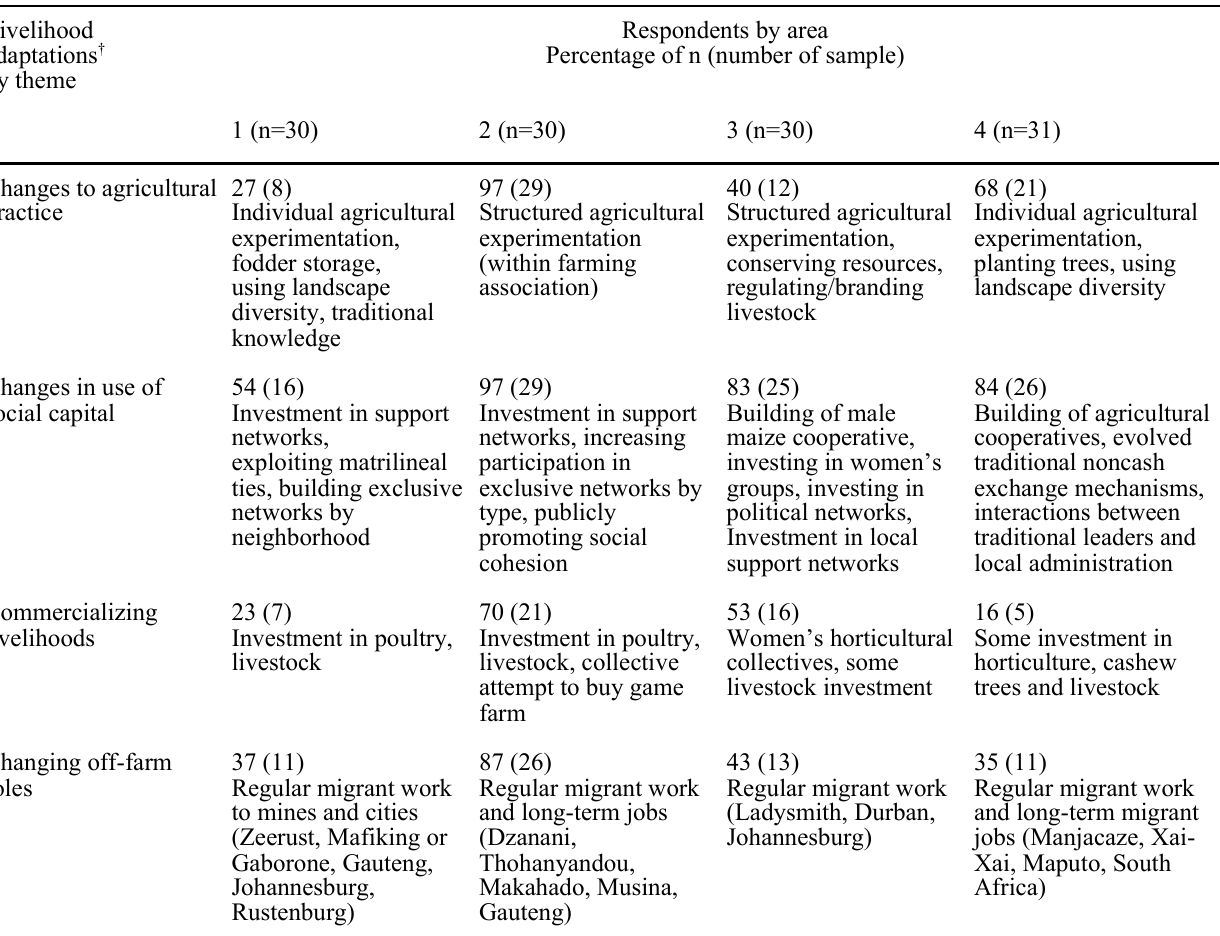
Table 3. Summary of adaptation characteristics across the study areas. Livelihood adaptations